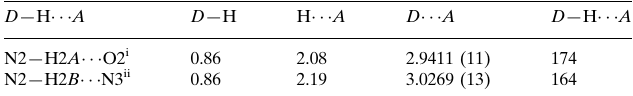
Hydrogen-bond geometry (A˚ , (cid:2)